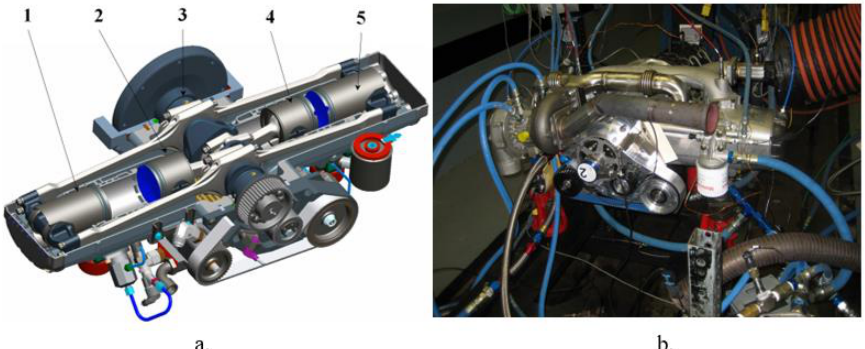
Figure 1. ( a ) The scheme of the engine with opposed pistons (EM100D): 1 — Outer exhaust piston; 2 — Inner intake piston; 3 — Crankshaft; 4 — Inner exhaust piston; 5 — Outer exhaust piston; ( b ) The EM100D on the test bench.